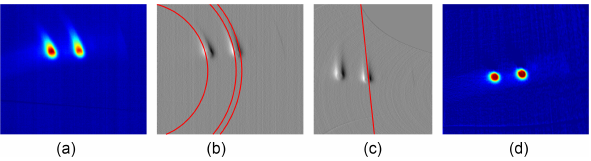
Figure 15. Infrared image of two small balls circularly moving (a) , gradient image to determine the rotation centre (b) , image trans- formed to linear motion (c) and the restored image (d)